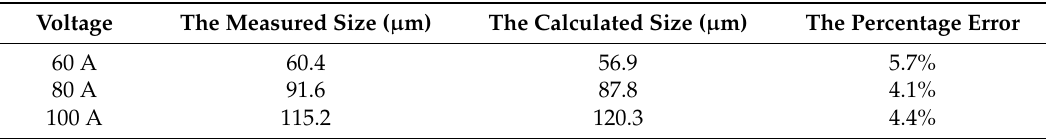
Table 4. The comparison of the average grain size between the measured and calculated heat-affected zone (HAZ) under different welding currents. The Measured Size ( µ